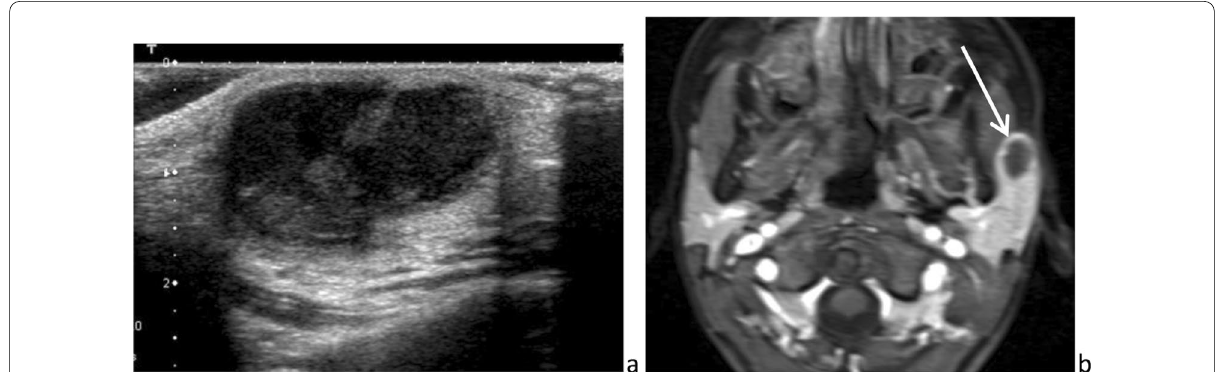
Fig. 6 Cat scratch disease. Left, intraparotid necrotic lymphadenitis: ultrasonography ( a ); axial T 1 ‑weighted image, after intravenous administration of gadolinium chelate ( b )